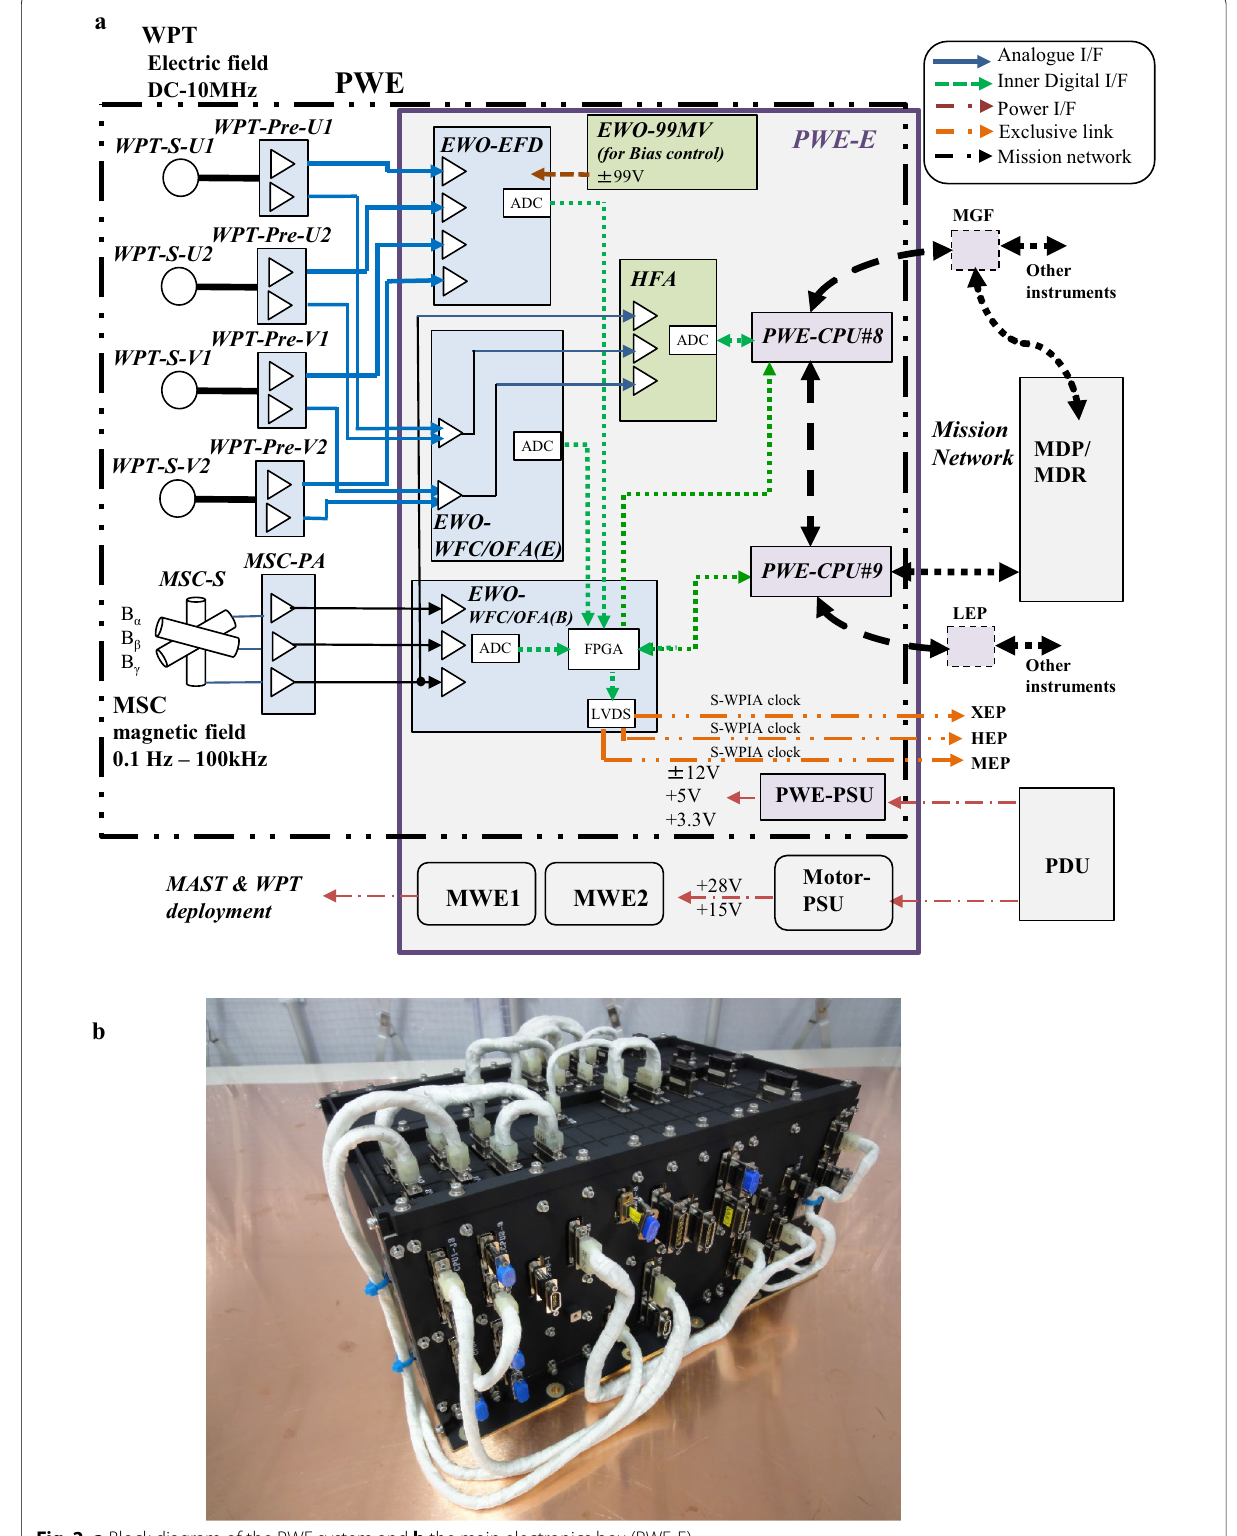
Fig. 2 a Block diagram of the PWE system and b the main electronics box